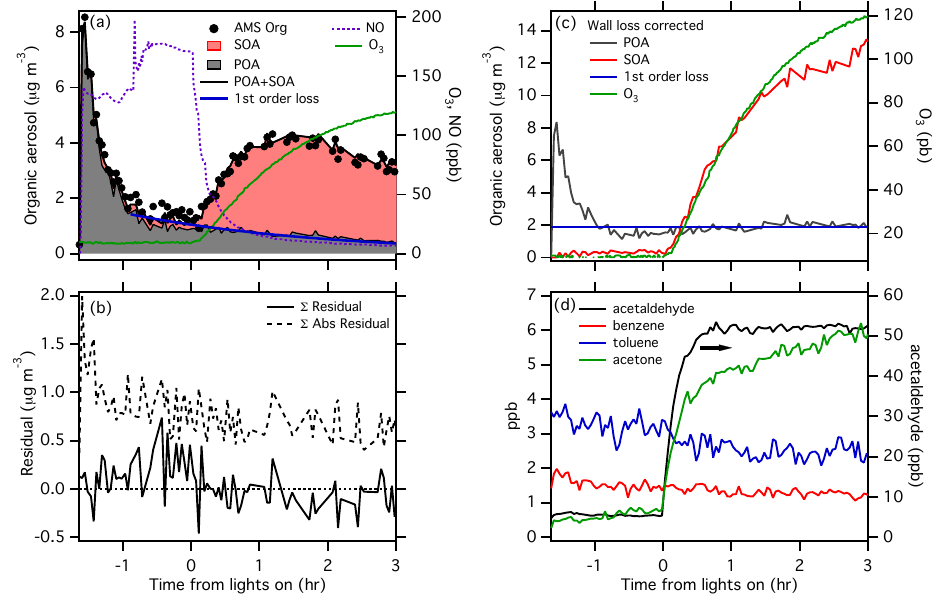
Figure 1. Time series of a typical experiment (LEV1-5.2). (a) Diluted exhaust was introduced to the chamber starting at t = − 1 . 4h and coincides with increases in OA and NO concentrations in the chamber. Chamber filling ended at t = − 0.74h, at which point HONO and propene were added to the chamber; addition of HONO also introduces additional NO. The observed OA concentration increased after the start of oxidation, indicating production of SOA. Red and grey shading indicate the POA and SOA factors determined from PMF analysis. The blue line shows a predicted first-order wall loss rate for POA after the completion of the driving cycle based on black carbon wall loss. (b) Residual of the PMF solution. (c) Particle-phase concentrations from (a) after corrections for wall losses. (d) Concentrations of selected VOCs as measured with a